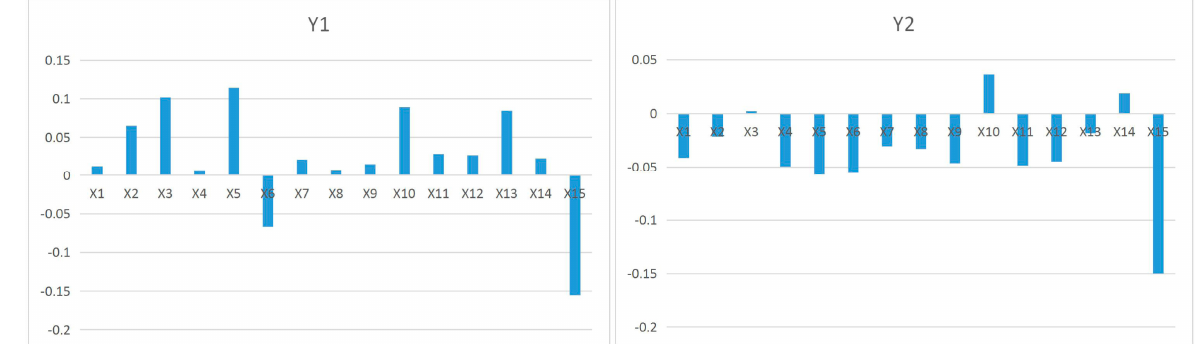
Figure 5. The q-value of the factor detector result.